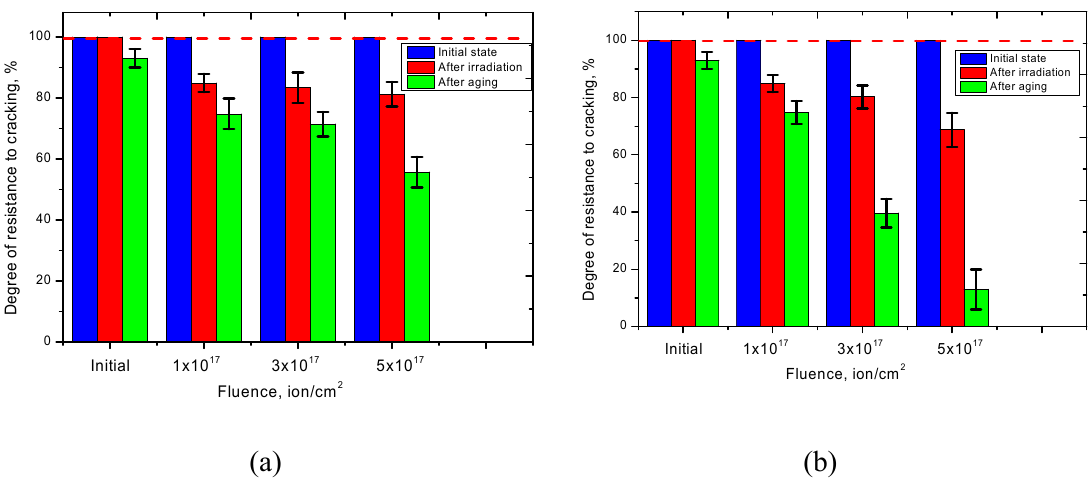
Figure 7. Diagram of the dependence of changes in the degree of resistance to cracking: ( a ) proton irradiation; ( b ) helium ion irradiation.